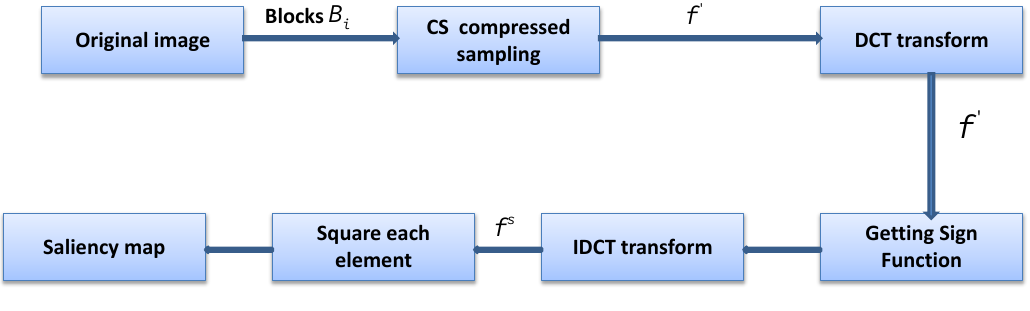
Figure 2. Diagram of extracting a saliency map in the measurement domain based on CS